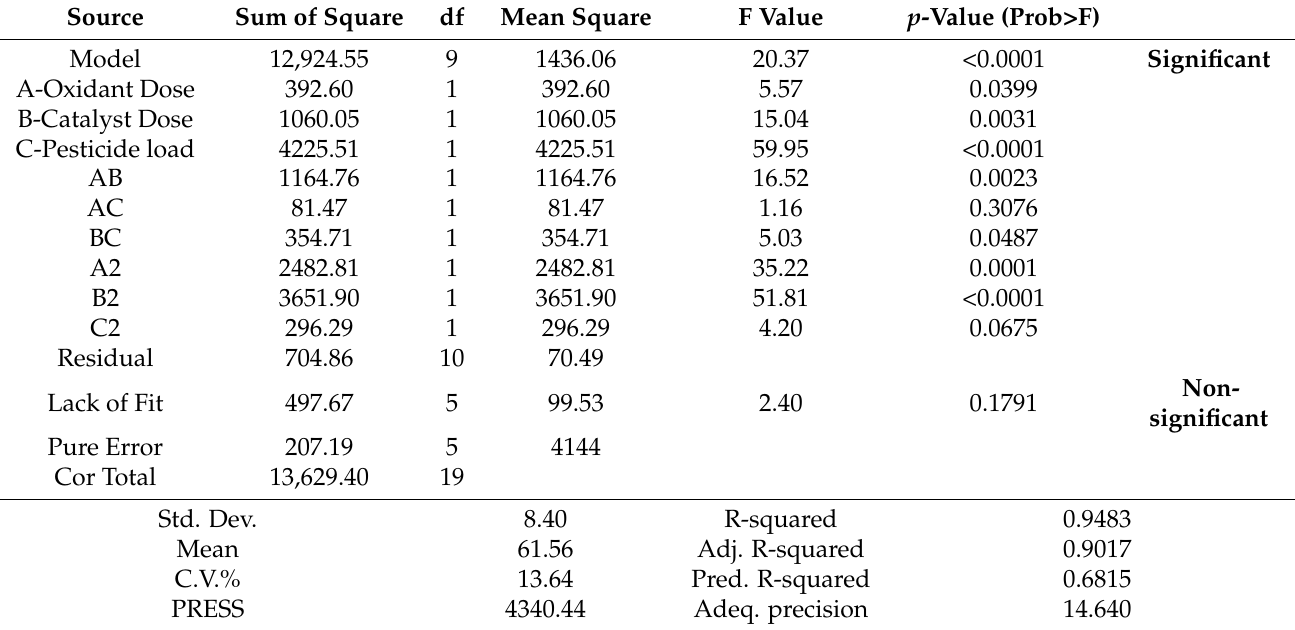
Table 4. ANOVA results of quadratic model for degradation of acetamiprid using GO-CoFe 2 O 4